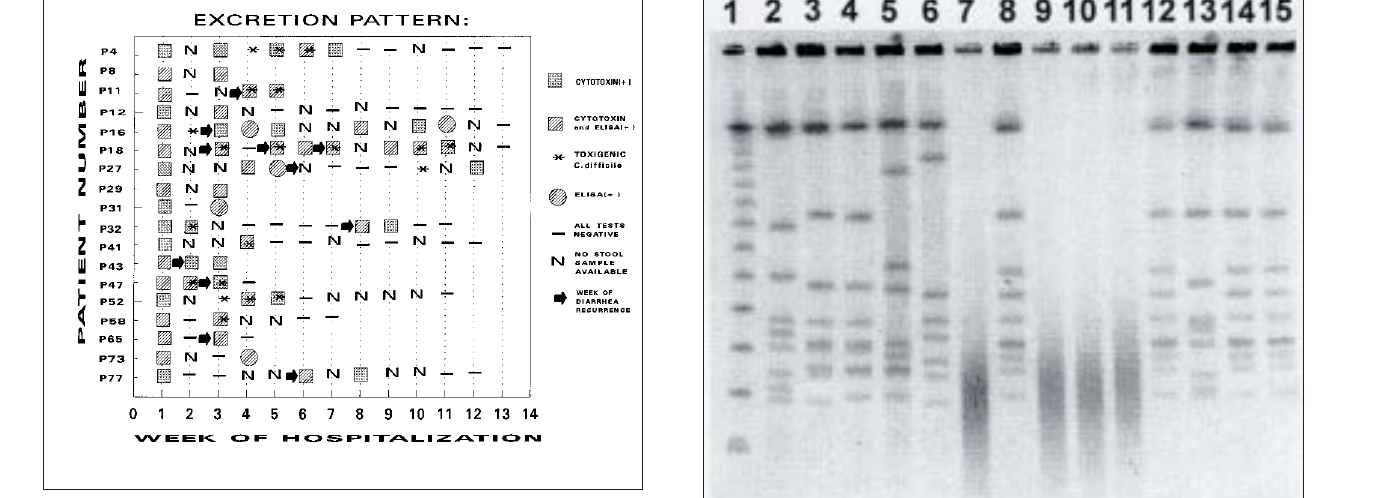
Figure 3) Excretion pattern in patients treated with antibiotics for